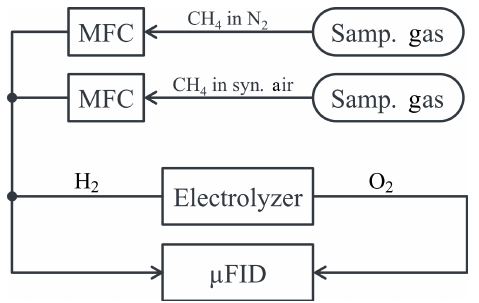
Figure 5. Schematic drawing of the setup to determine the sensitiv- ity towards oxygen of the µFID using mass flow controllers (MFCs) to control the sample gas